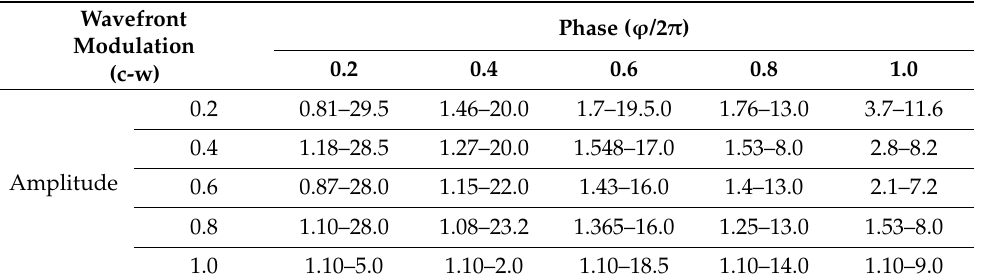
Table 1. The specific phase/amplitude value and corresponding parameters of c-w.